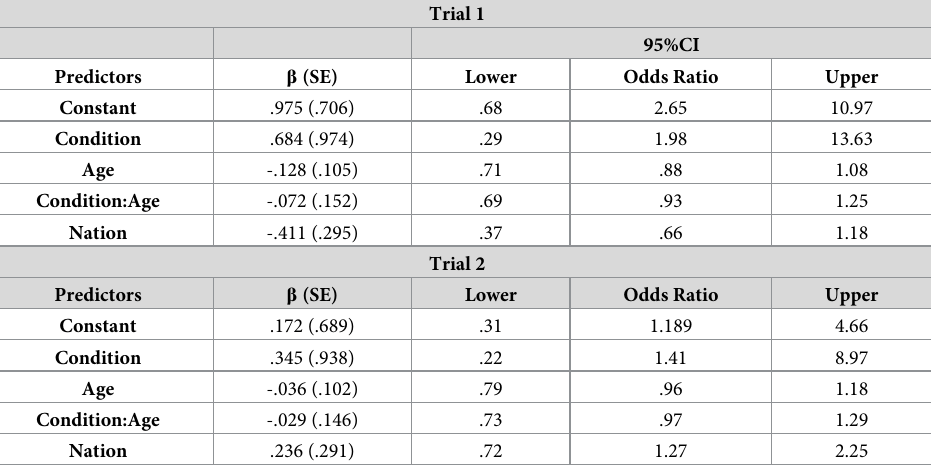
Table 1. β and Odds Ratios for the logistic regression for both